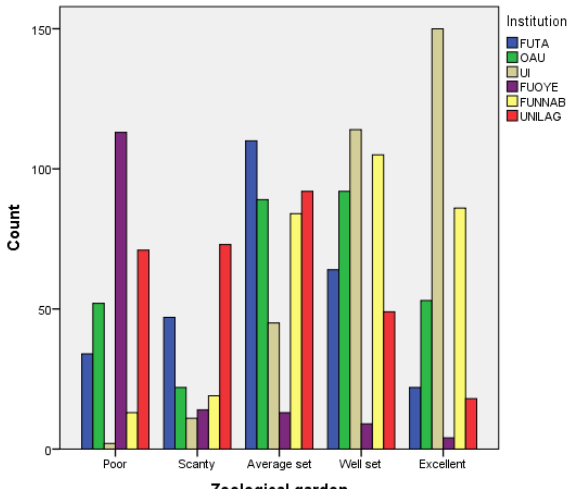
Figure 3. Differences in the perceptions of qualities of Zoological gardens among the six Federal Universities’ campuses in South- west Nigeria. perception of qualities Zoological gardens. Only discipline (Cramer’s